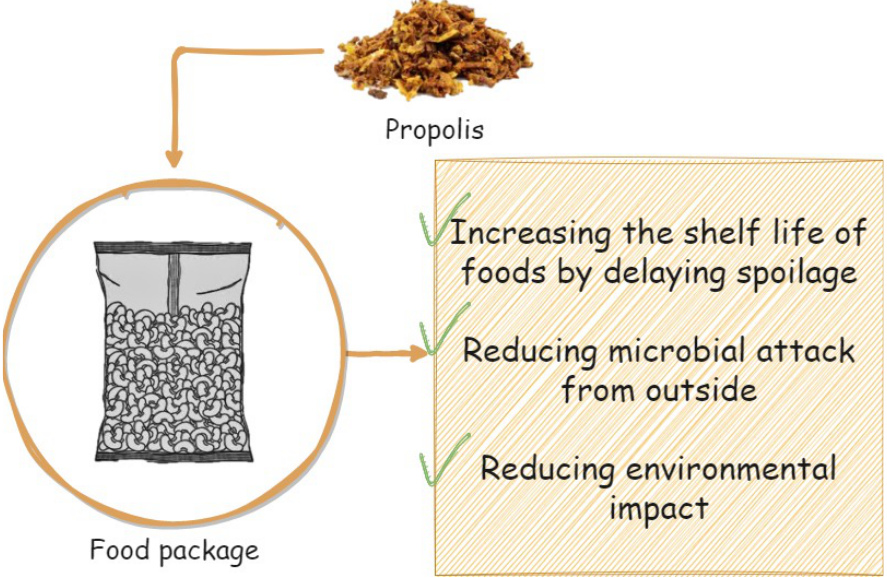
Figure 3. Benefits of propolis in food packaging .